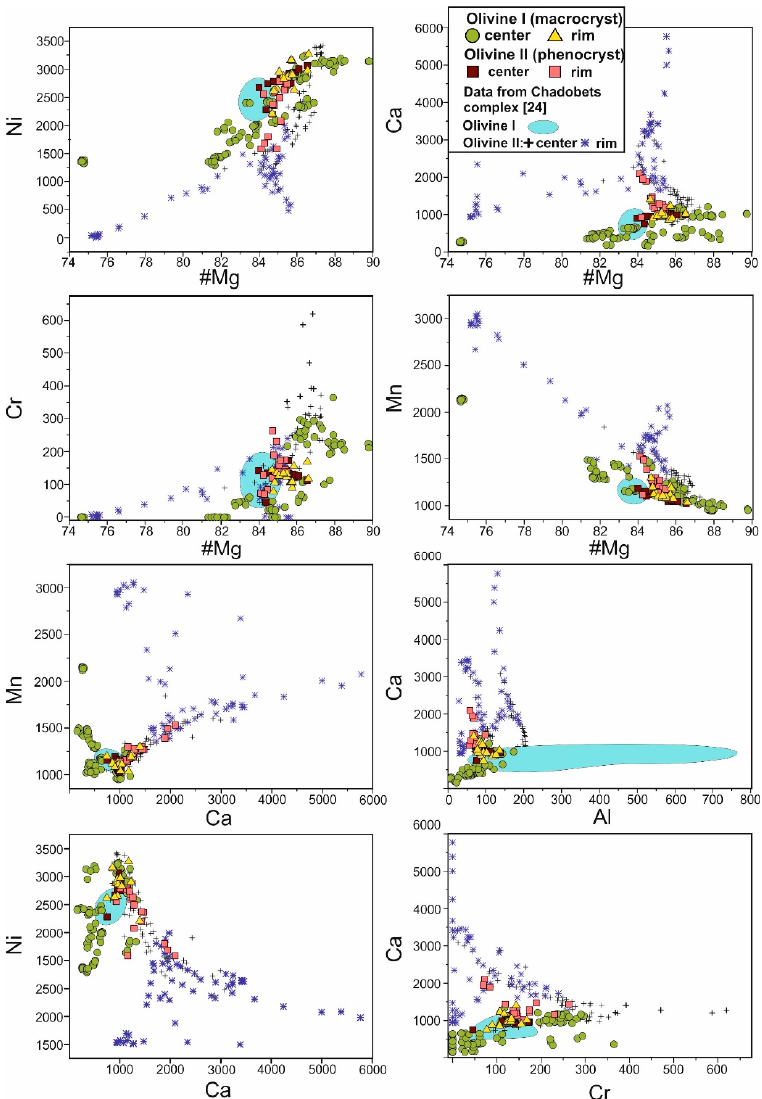
Figure 8. Diagrams of the variation in #Mg vs. Ni, Cr, Ca, and Mn, and Ca vs. Mn, Al, Ni, and Cr in olivine macrocrysts (olivine-I) and phenocrysts (olivine-II) of the Terina complex UML rocks, as determined by WDS analyses (ppm). The legend for the plots is shown as an insert in the second graph. The figure also contain the data for the Chadobets complex from [9].